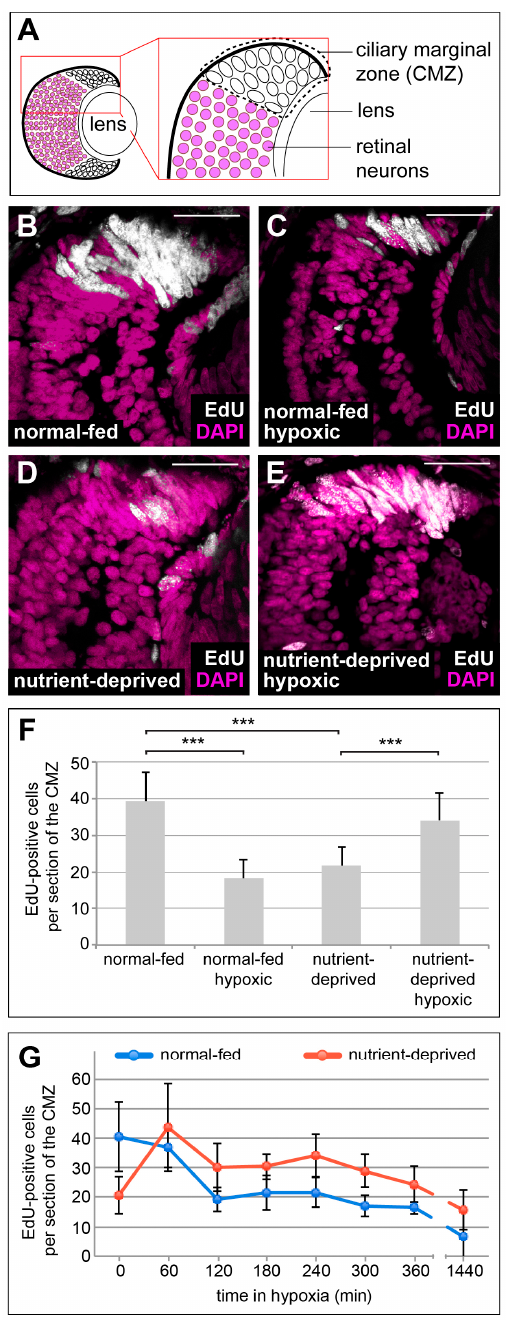
Figure 1. Hypoxia affects proliferation of progenitors in the retinal stem cell niche in the opposite manner, dependent on the nutritional status. ( A ) Schematic representation of a cross section through a 38-stage Xenopus retina, indicating the position of the ciliary marginal zone (CMZ). ( B – E ) EdU incorporation measured after a 2 h EdU pulse in DAPI-stained retinas from animals that have been normal-fed ( B , C ) or nutrient-deprived for 24 h ( D , E ) incubated under normoxia ( B , D ) or hypoxia ( C , E ). Nutrient deprivation or hypoxia reduced the number of proliferating cells in the CMZ, whereas hypoxic nutrient-deprived retinas show an increase of proliferation in the CMZ. Scale bars = 50 µm. For each condition, between 10 and 15 retinas were quantified. ( F ) Quantification of the experiment performed in ( B – E ). Error bars represent standard deviations. Two hooked ends of horizontal lines indicate the two conditions compared, *** p -value < 0.001; n = 7. ( G ) Quantification of EdU-positive cells after an 1 h EdU incorporation in retinas from normal-fed (blue line) or nutrient-deprived (red line) animals after various times in hypoxia (time in minutes indicated on the x-axis). Error bars represent standard deviations of two independent experiments ( n = 2). For each condition and time point, a minimum of 10 retinas was quantified.